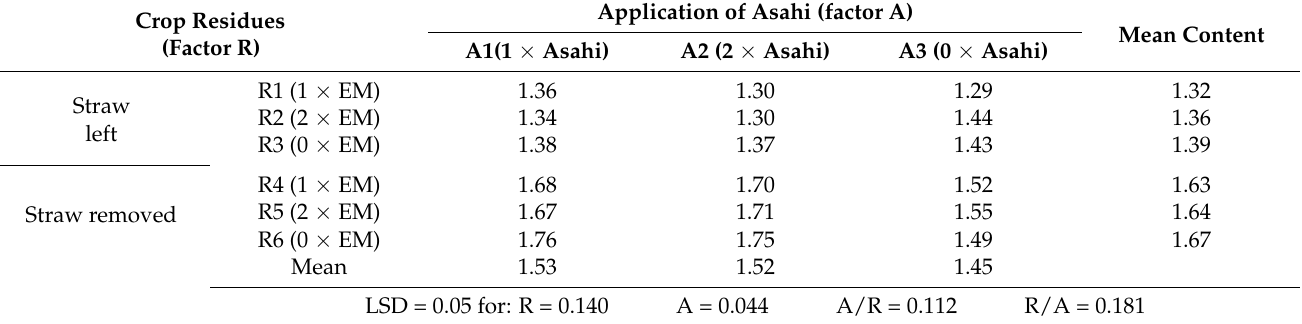
Table 2. Soil penetration resistance (SPR) (MPa) depending on the management of plant residues with the addition of the biopreparation EM (R factor) and the application of the biostimulant Asahi (A factor) in spring barley cultivation.